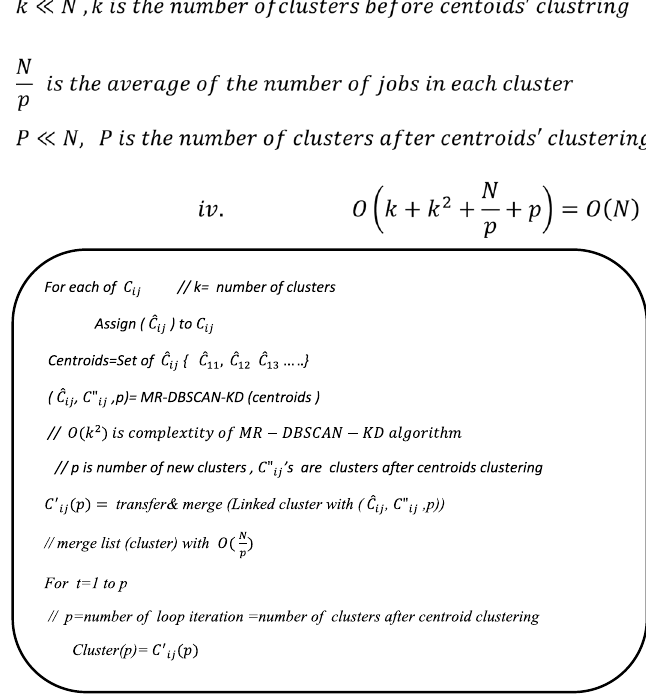
Algorithm 4 . Merging clusters based on